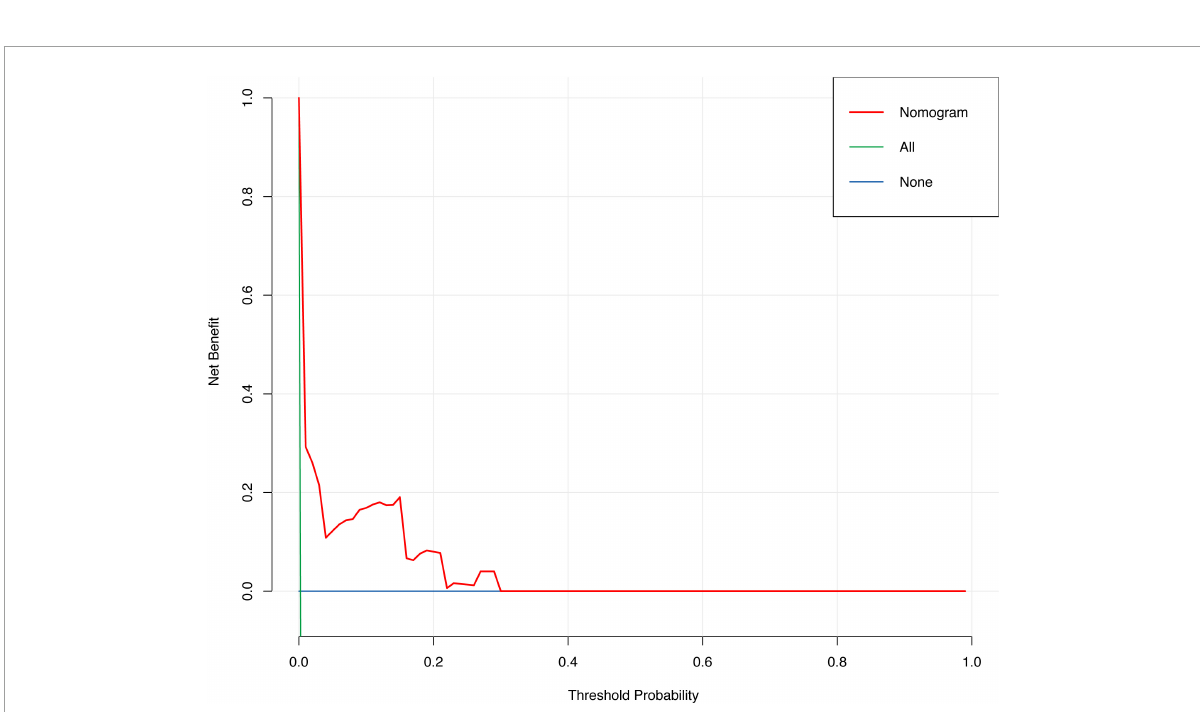
FIGURE7 Decision carve analysis of the nomogram predicting 30-day mortality after